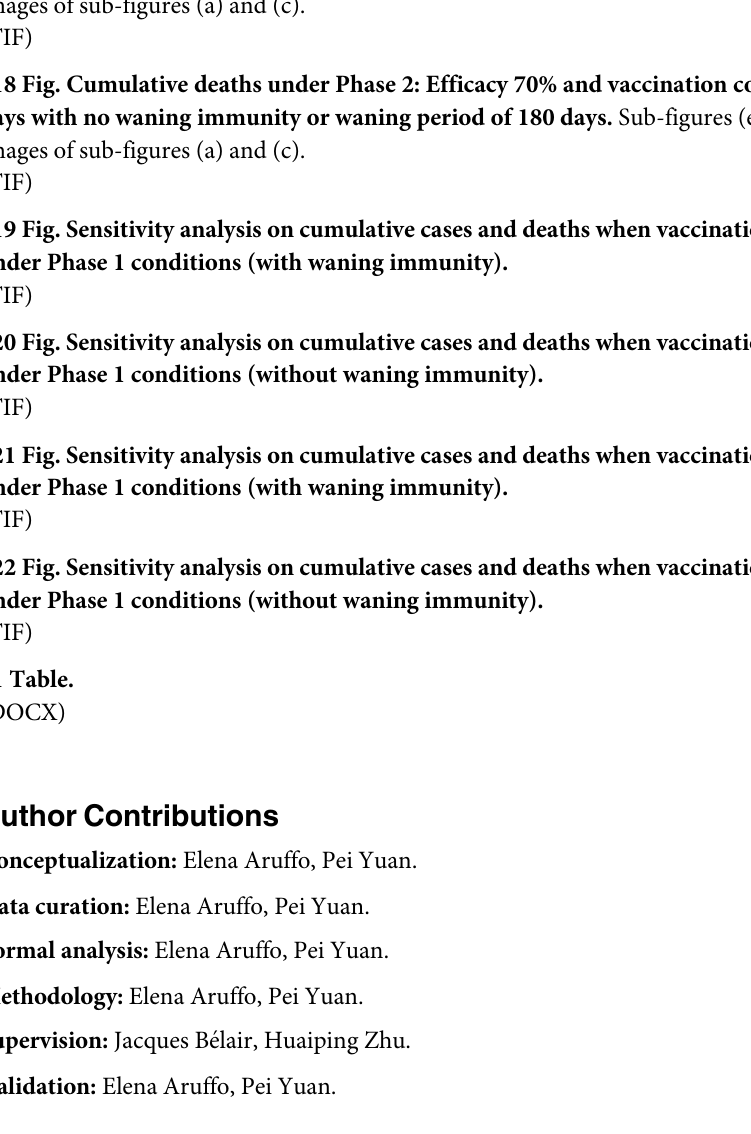
S14 Fig. Cumulative deaths under Phase 4: Efficacy 70% and vaccination completed in 120 days with no waning immunity or waning period of 180 days. S15 Fig. Cumulative cases under Phase 2: Efficacy 70% and vaccination completed in 120 days with waning period of 90 or 365 days. Sub-figures (e-f) are zoomed images of sub-fig- ures (a) and (c). S16 Fig. Cumulative cases under Phase 2: Efficacy 90% and vaccination completed in 120 days with no waning immunity or waning period of 180 days. Sub-figures (e-f) are zoomed images of sub-figures (a) and (c). S17 Fig. Cumulative cases under Phase 2: Efficacy 70% and vaccination completed in 360 days with no waning immunity or waning period of 180 days. Sub-figures (e-f) are zoomed images of sub-figures (a) and (c). S18 Fig. Cumulative deaths under Phase 2: Efficacy 70% and vaccination completed in 120 days with no waning immunity or waning period of 180 days. Sub-figures (e-f) are zoomed images of sub-figures (a) and (c). S19 Fig. Sensitivity analysis on cumulative cases and deaths when vaccination is introduced under Phase 1 conditions (with waning immunity). S20 Fig. Sensitivity analysis on cumulative cases and deaths when vaccination is introduced under Phase 1 conditions (without waning immunity). S21 Fig. Sensitivity analysis on cumulative cases and deaths when vaccination is introduced under Phase 1 conditions (with waning immunity). S22 Fig. Sensitivity analysis on cumulative cases and deaths when vaccination is introduced under Phase 1 conditions (without waning